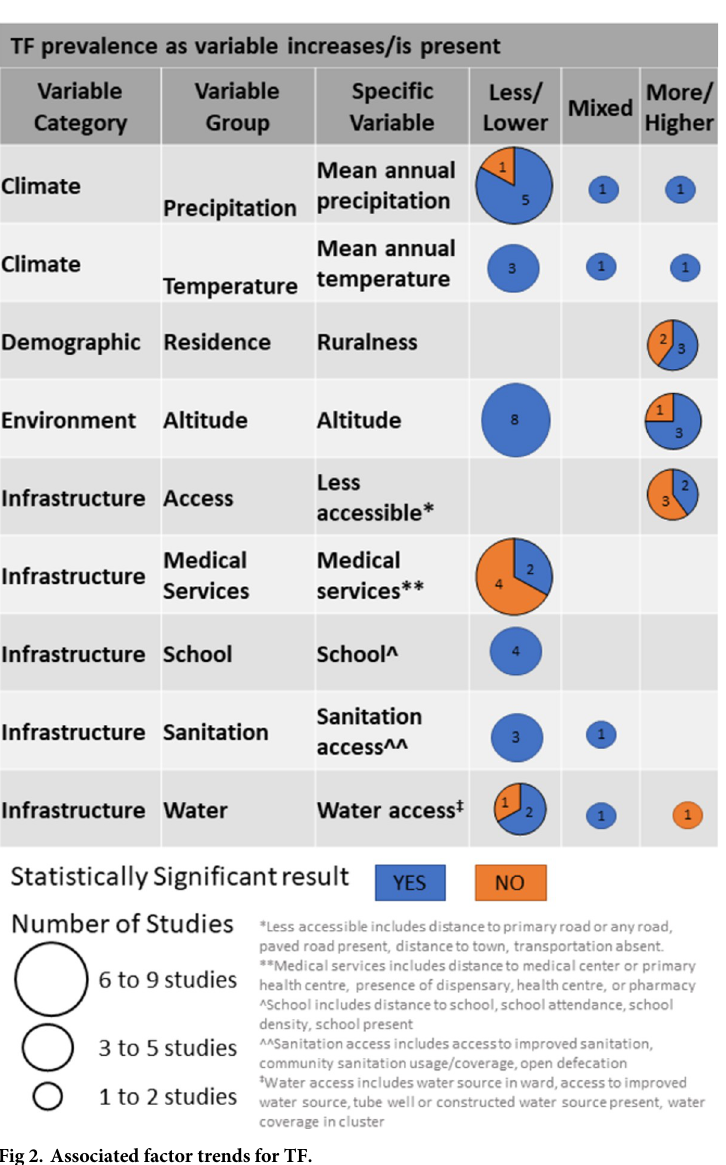
Fig 2. Associated factor trends for